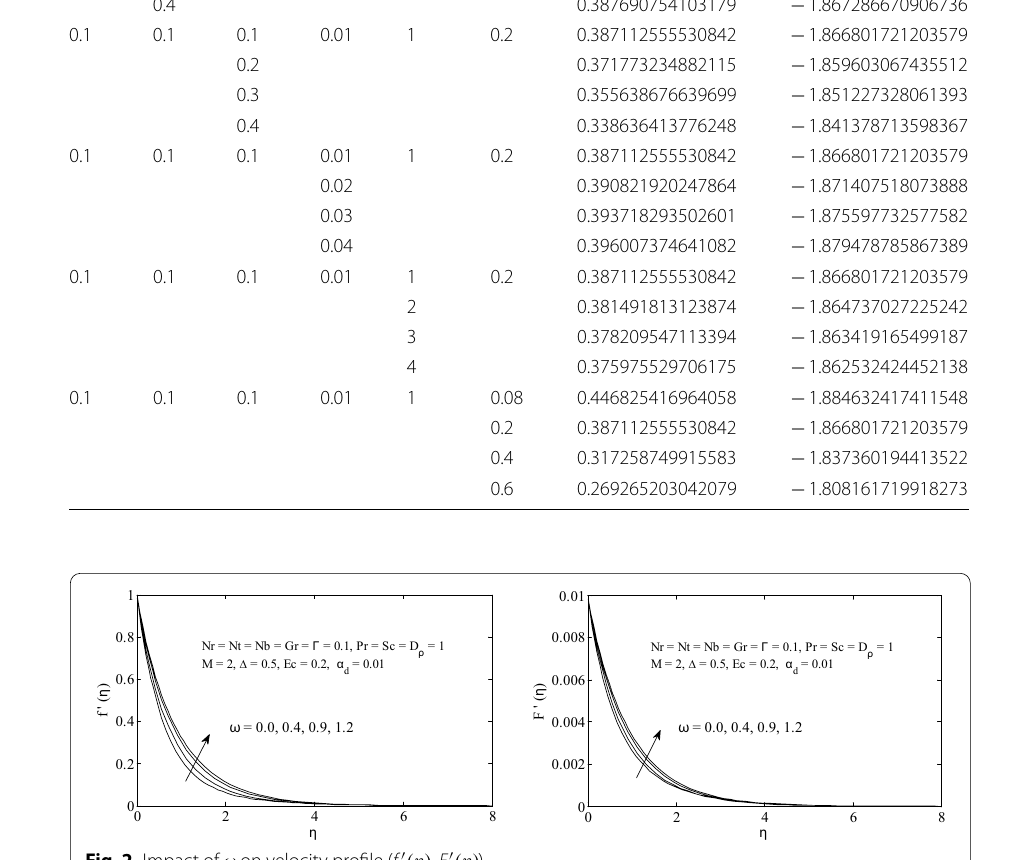
Fig. 2 Impact of ω on velocity profile ( f ′ (η) , F ′ (η) )